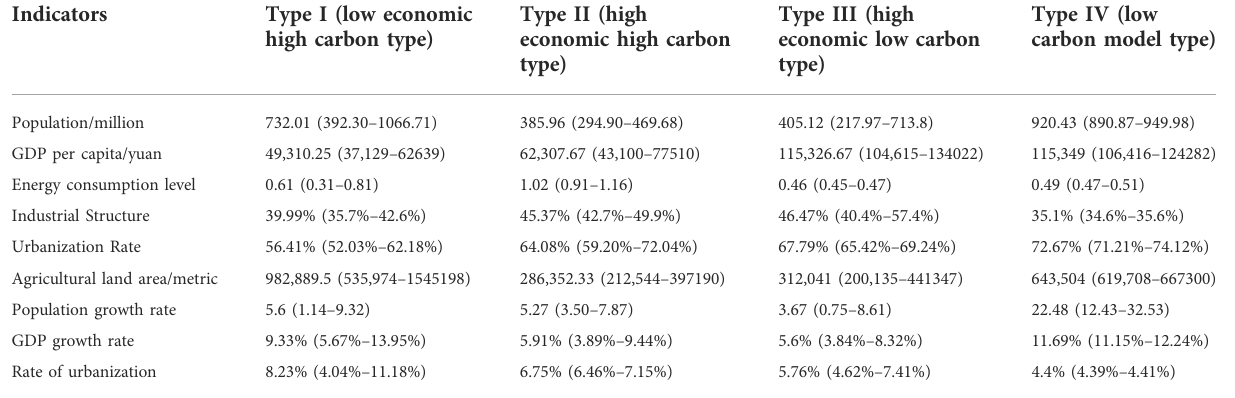
TABLE 5 Range of indicators for each type of